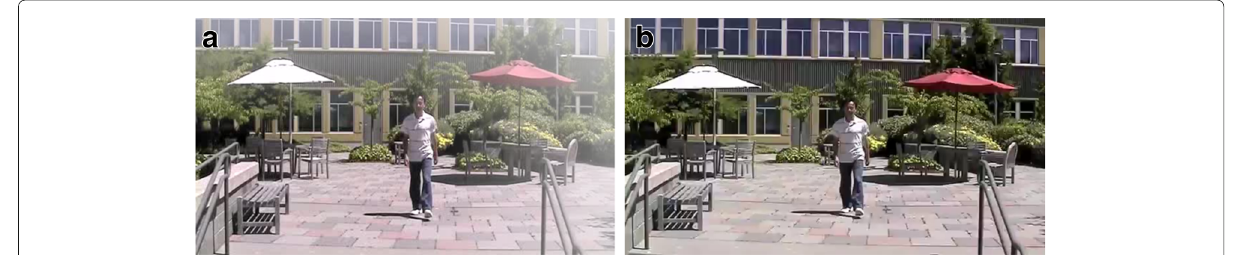
Fig. 8 Video #3 . Amount of pixels hold through our method is comparable to the state-of-the-art approach. a Adaptive Gaussian